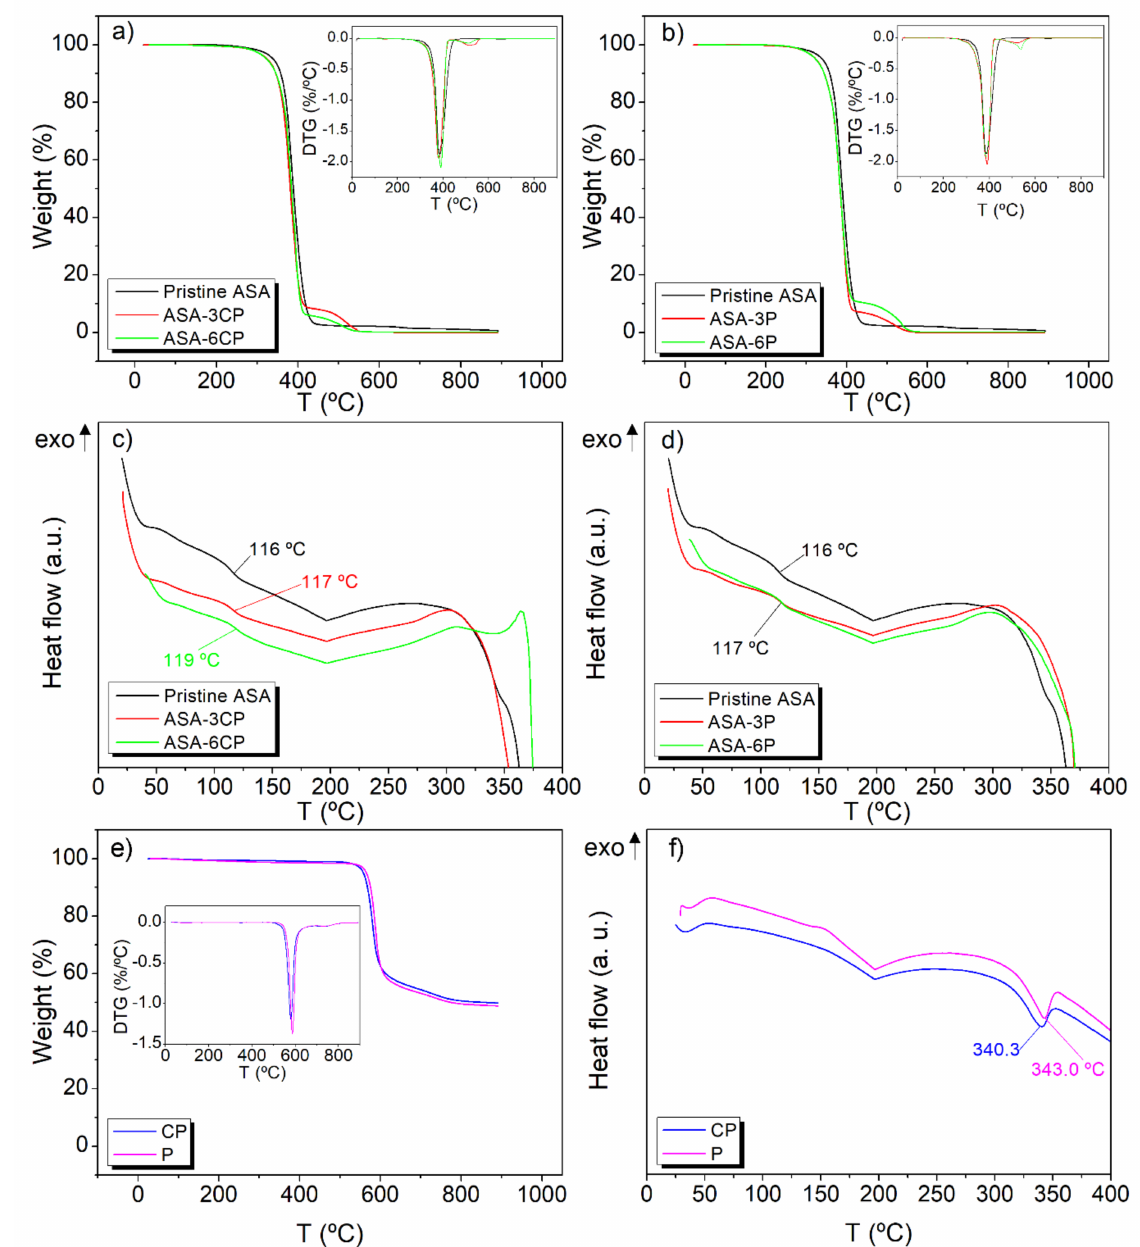
Figure 6. TGA thermograms of pristine ASA and ( a ) ASA-CP composites, and ( b ) ASA-P composites, (the corresponding DTG curves are included, respectively, in the insets); DSC curves of pristine ASA and ( c ) ASA-CP composites, and ( d ) ASA-P composites; ( e ) TGA thermograms of CP and P (with the corresponding DTG curves in the inset), and ( f ) DSC curves of CP and